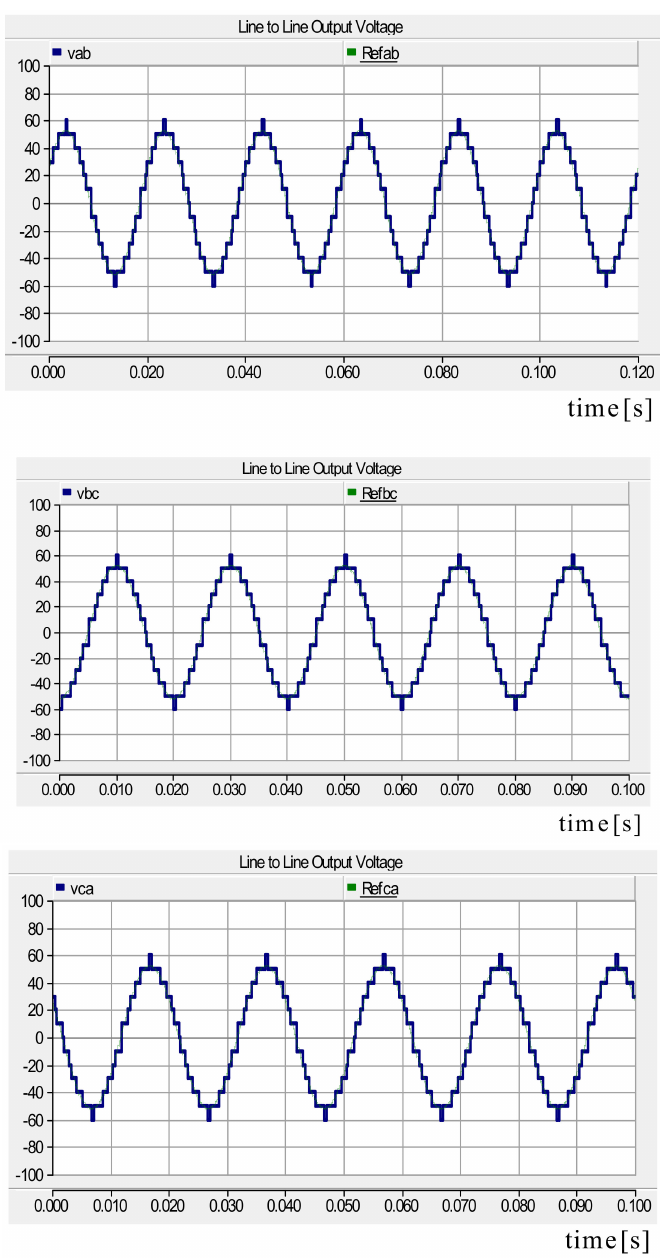
Figure 8. Lin-to-line output voltage